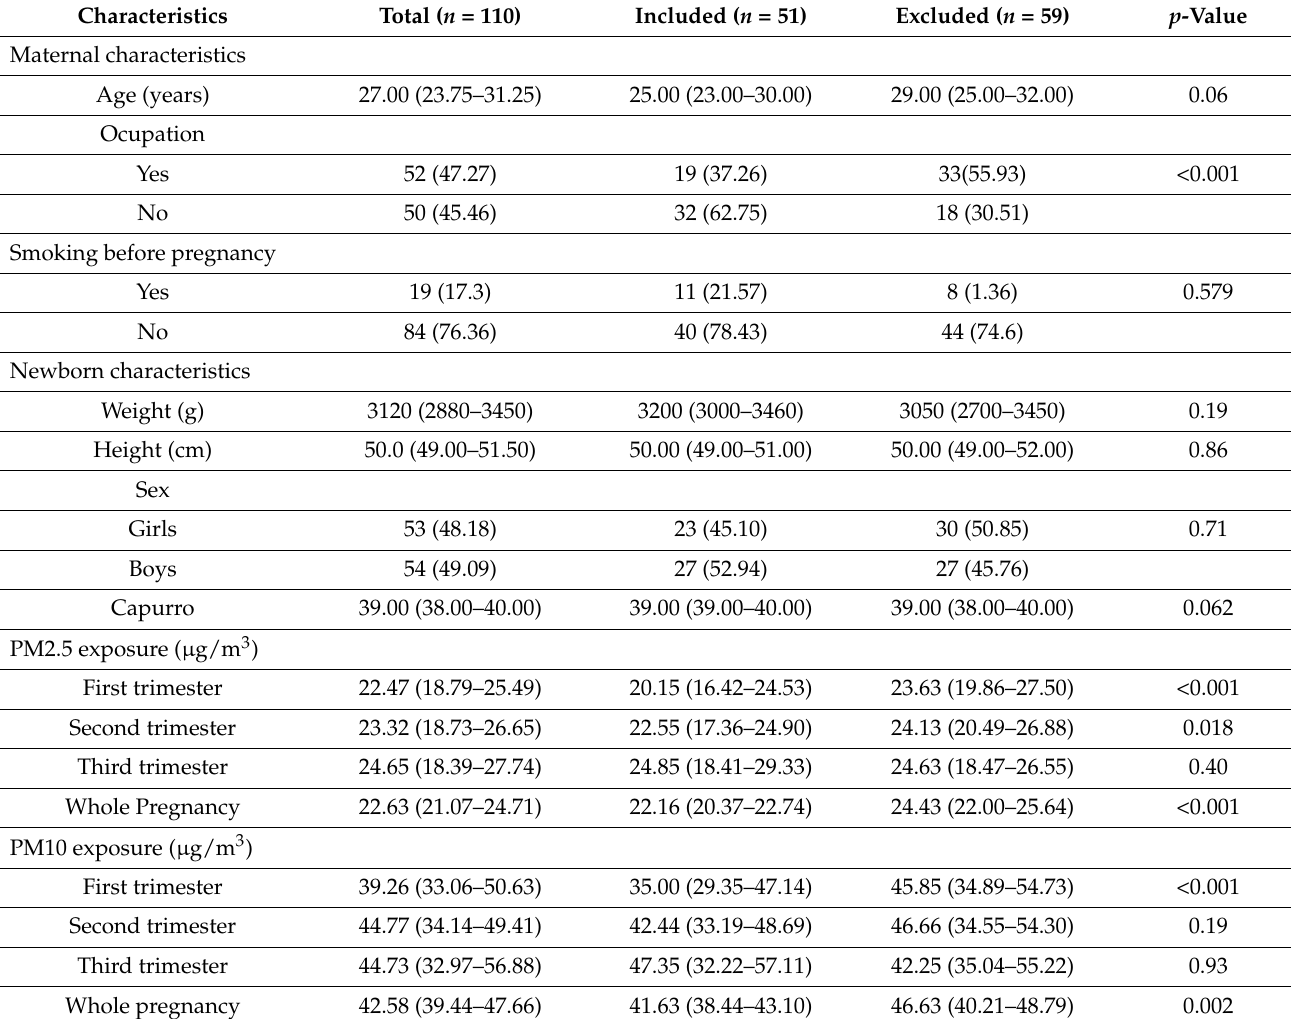
Table 1. Maternal and newborn characteristics in 110 participants from CIMIGEN Clinic in Mexico City.